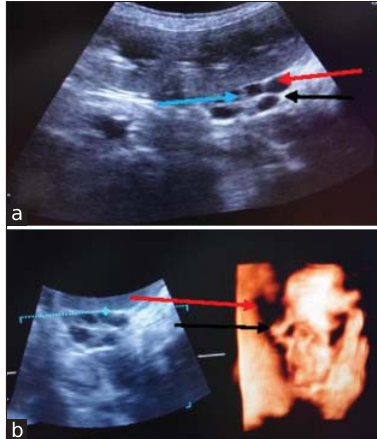
Figure-7: Polycystic kidney: (a) In two-dimensional ultrasonogram of kidney, six anechoic fluid filled structures (red arrow), thin renal parenchyma with indistinct kidney margins (black arrow) and renal divarticulae (blue arrow), (b) in three-dimensional ultrasonogram of kidney, anechoic fluid filled structures (red arrow), and renal diverticulae (black